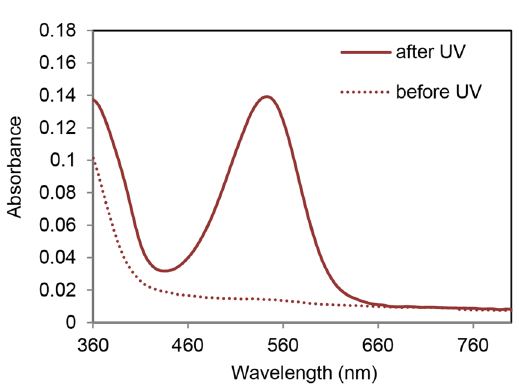
Figure 3. Absorbance spectra of N -nitroBIPS-DPPG before and after UV irradiation. The absorption spectra of a DOPC/ N -nitroBIPS-DPPG (9:1) dispersion (1 mM) in PBS was recorded as described in EXPERIMENTAL SECTION. Representative data of three independent